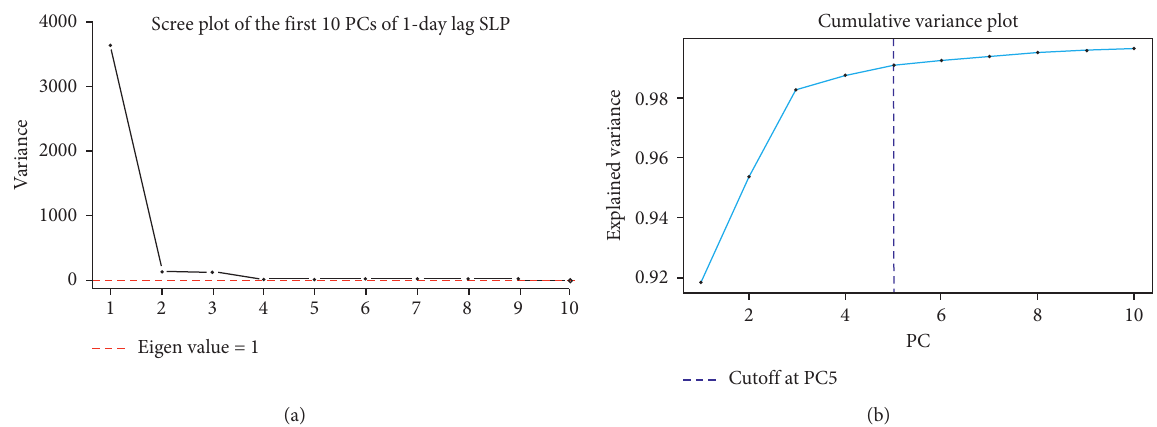
Figure 8: (a) The scree plot and (b) cumulative variance plot of the first ten principal components of one-day lag sea level pressure data over the climate domain of Peninsular